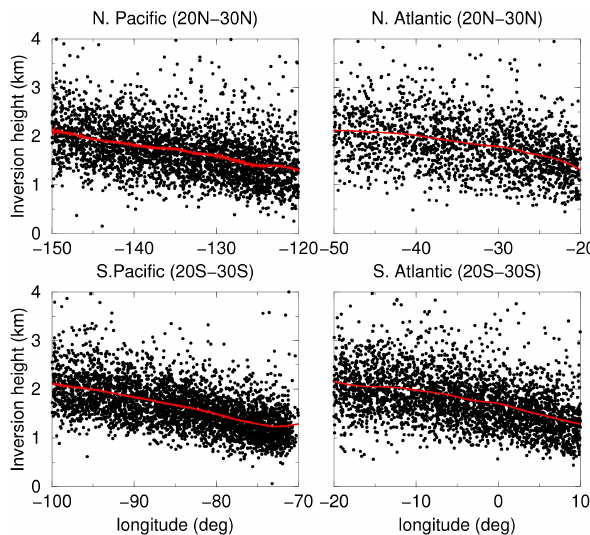
Fig. 25. Variation of the ABL top with longitude over the North and South Pacific and North and South Atlantic over a three-year period (2007–2009). Data constrained by strength of inversion layer defined by the vertical gradient in bending angle greater than 0.01 rad. Top left: North Pacific averaged between 20 ◦ N and 30 ◦ N. Top right: North Atlantic averaged between 20 ◦ N and 30 ◦ N. Lower left: South Pacific averaged between 20 ◦ S and 30 ◦ S. Lower right: South Atlantic averaged between 20 ◦ S and 30 ◦ S (Sokolovskiy, 2010, personal communication. A similar figure was shown by Sokolovskiy et al., 2010).